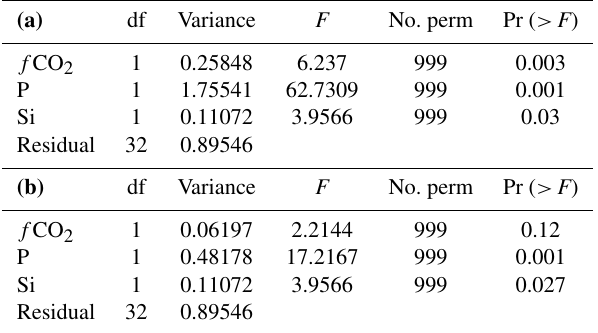
Figure 11. Canonical analysis of principal co-ordinates (CAP) based on the similarity in protistan community structure among f CO 2 treatments and times over days 8 to 18 of the incubation, showing the trajectory of change in the protistan community for each f CO 2 level (coloured arrows) based on the abundance of the component taxa/functional groups. Arrow starting points are day 8 and all arrows end on day 18 of the experiment. Linear projections of significant constraints CO 2 , Si and P appear as blue linear arrows. Table 3. Permutation tests assessing the significance of each envi- ronmental covariate (constraint) in determining protistan commu- nity structure using principal co-ordinates (CAP), with significance of each term when (a) sequential added (b) marginal effects for f CO 2 , P and